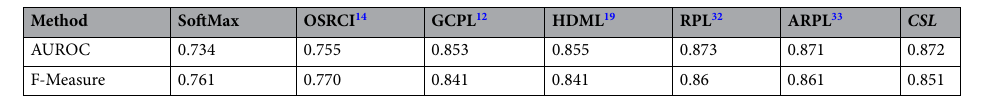
Table 1. The AUROC and F1 scores of body part open-set recognition on MURA dataset.